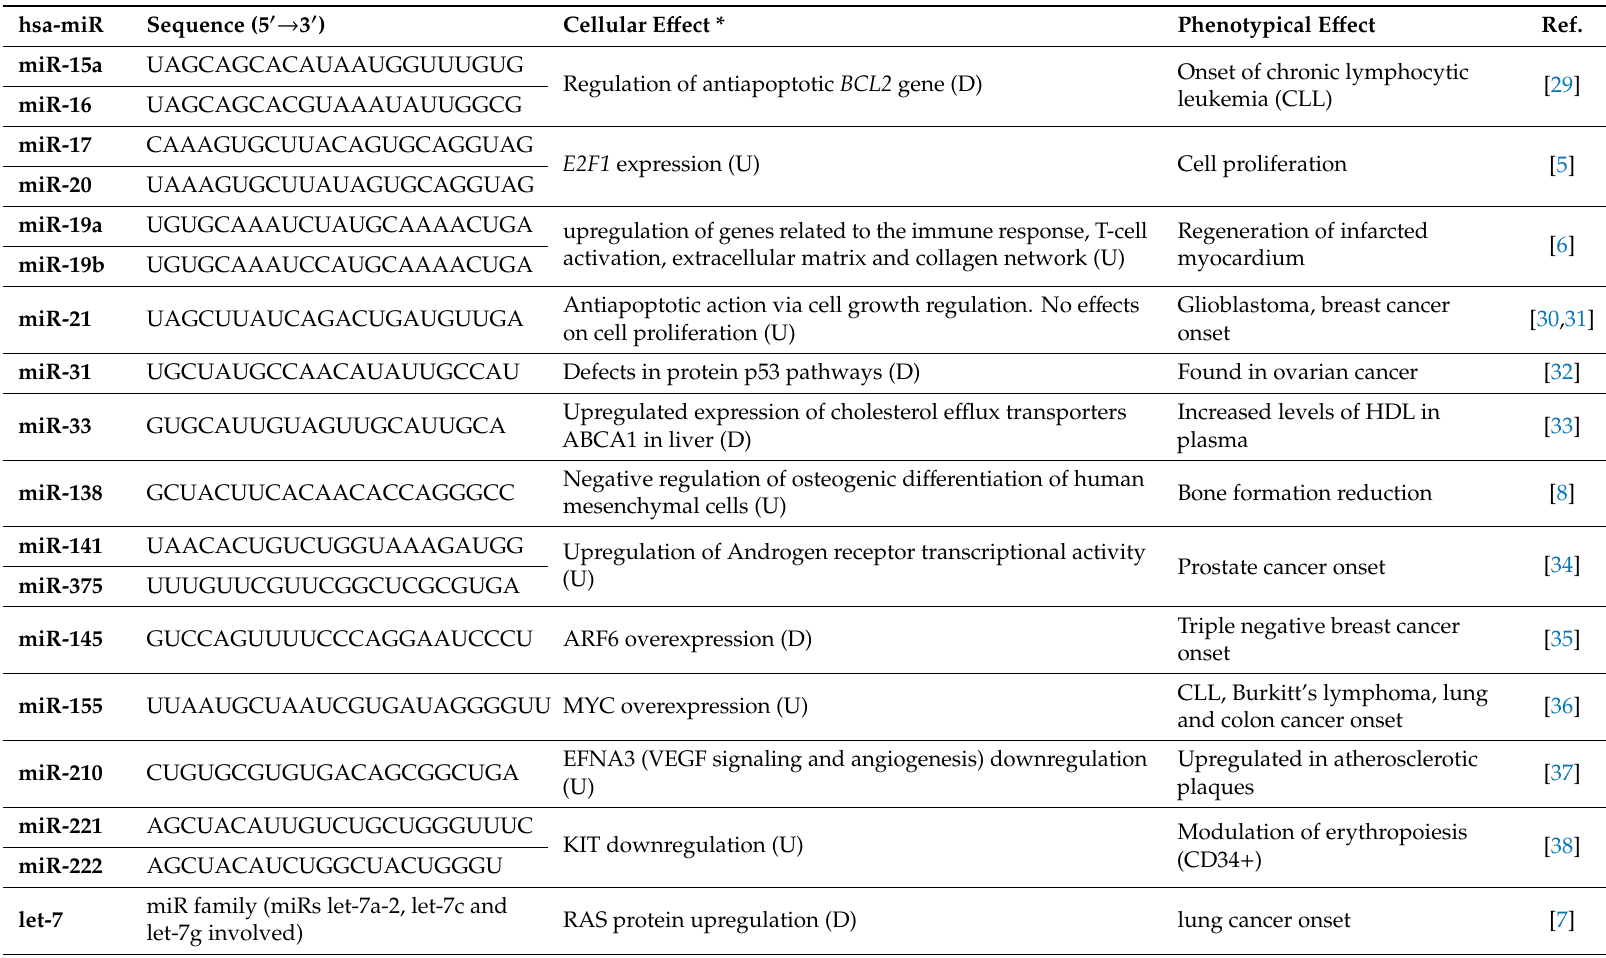
Table 1. Overview of the principal miRs reported, summarizing the cellular and phenotypical e ff ects of their upregulation or